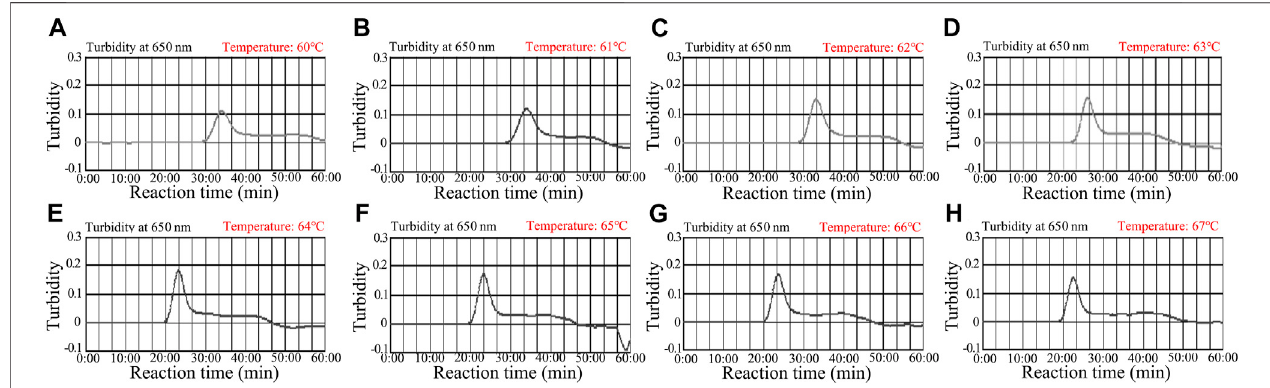
FIGURE4| Optimizationoftemperatureforthe N.gonorrhoeae -LAMPreaction.The N.gonorrhoeae -LAMPreactionsweremonitoredusingreal-timeturbidity(LA- 500),andthecorrespondingcurvesofampliconsareshowninthecharts.Thethresholdvaluewas0.1,andturbidity > 0.1wasconsideredtoshowpositiveampli fi cation. Eight kinetic graphs (A – H) were obtained at different temperatures (60 – 67 ° C, 1 ° C intervals) with 5.0 × 10 3 copies of genomic DNA from N. gonorrhoeae isolates (ATCC 49926). The optimal LAMP temperature was selected according to higher turbidity. The results indicated that the temperature of 64 ° C (E) showed robust ampli fi